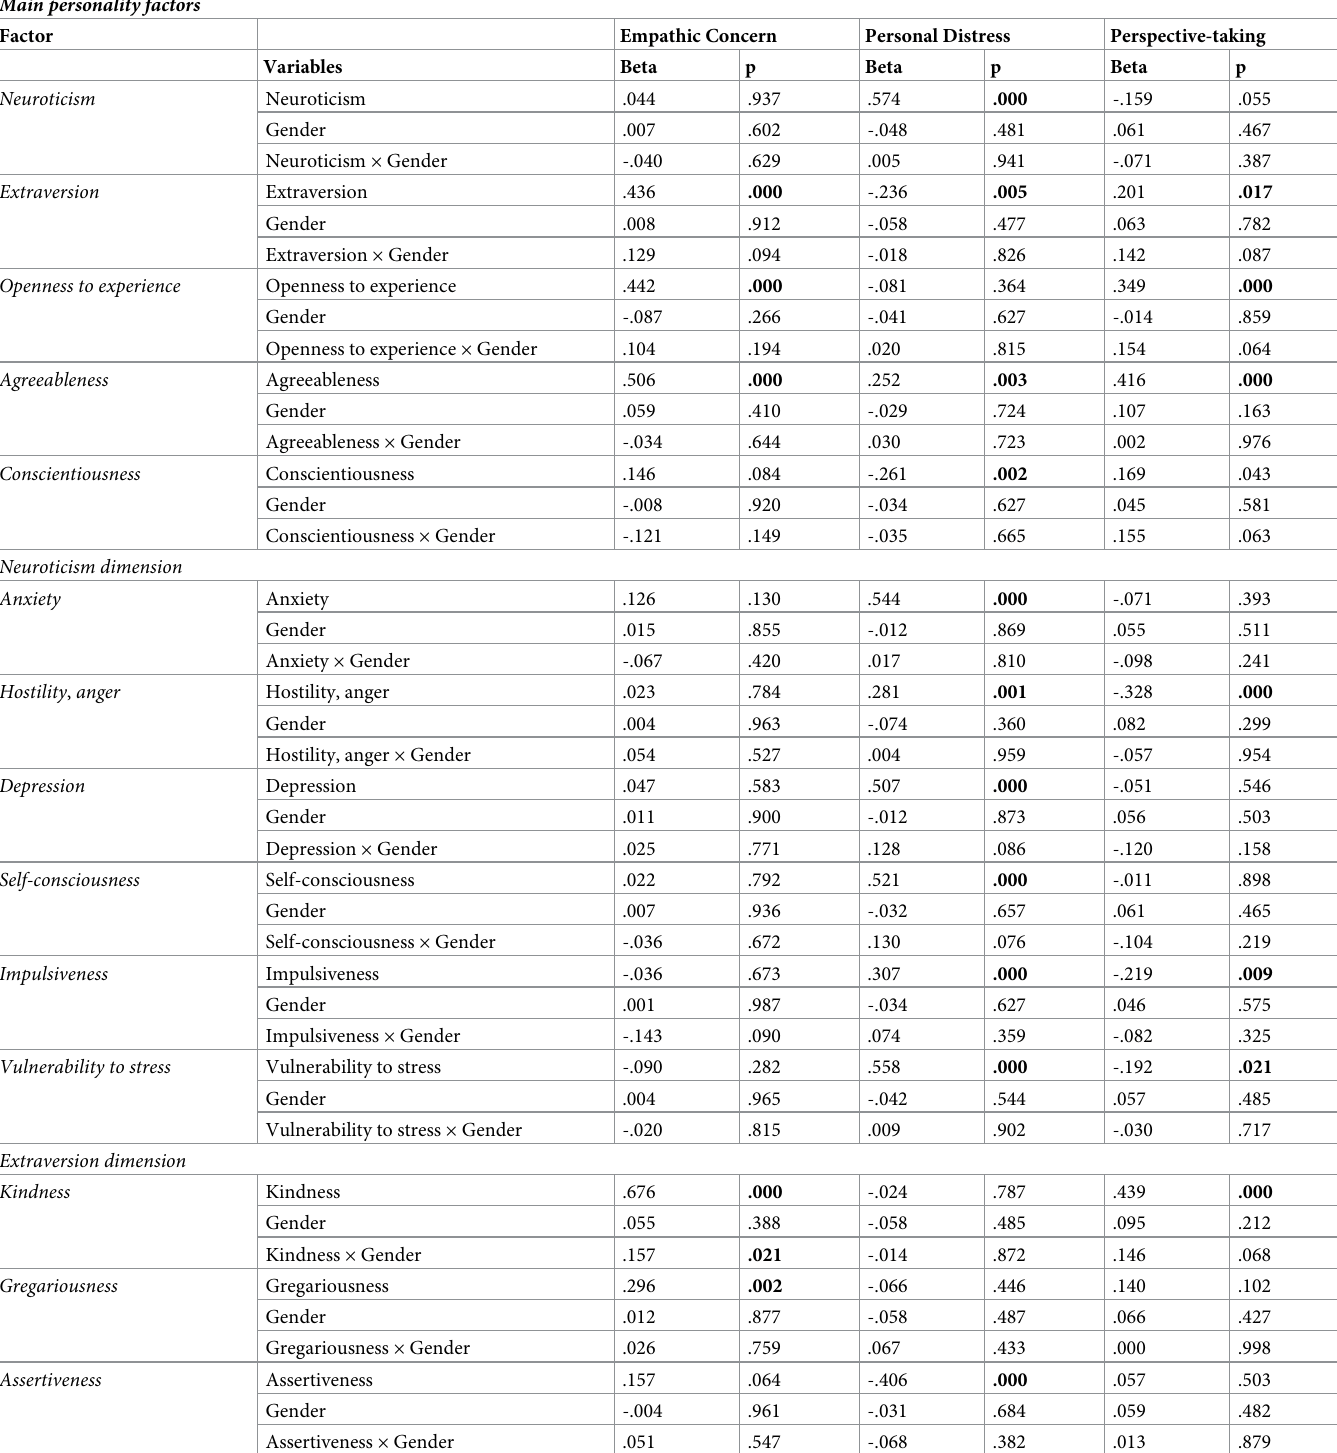
Table 3. The relationship between the level of empathy and personality